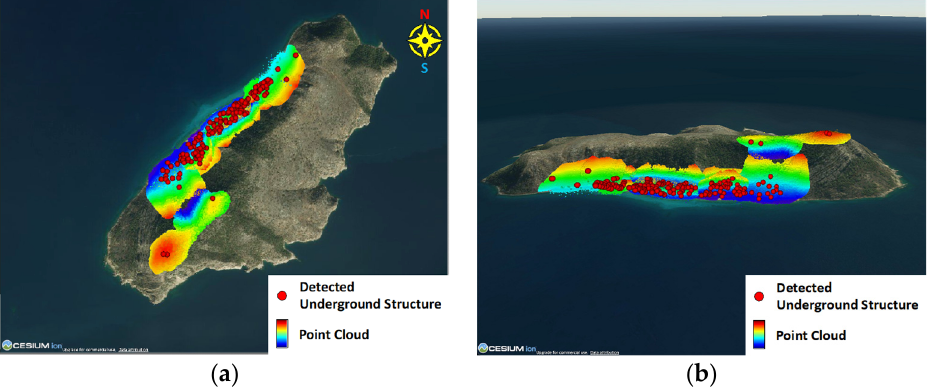
Figure 25. Illustrations of ( a ) top view (default) and ( b ) perspective view of the base map and UAV point cloud overlaid with detected underground structures in the Potree web-visualization portal.